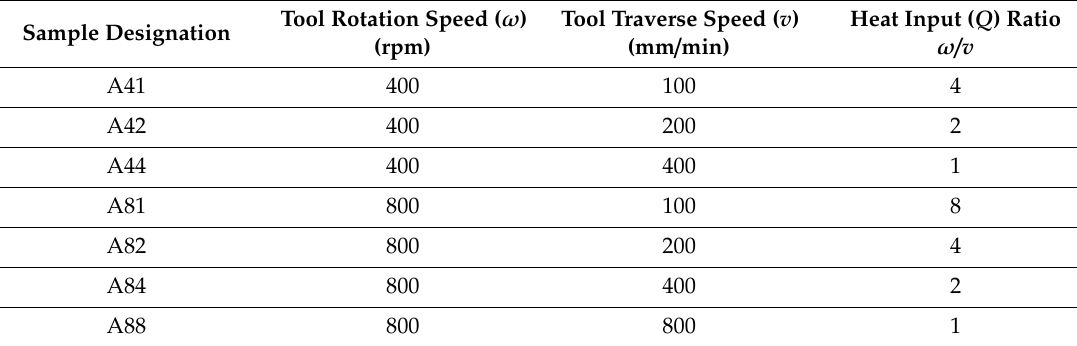
Table 4. Welding parameters for each sample with